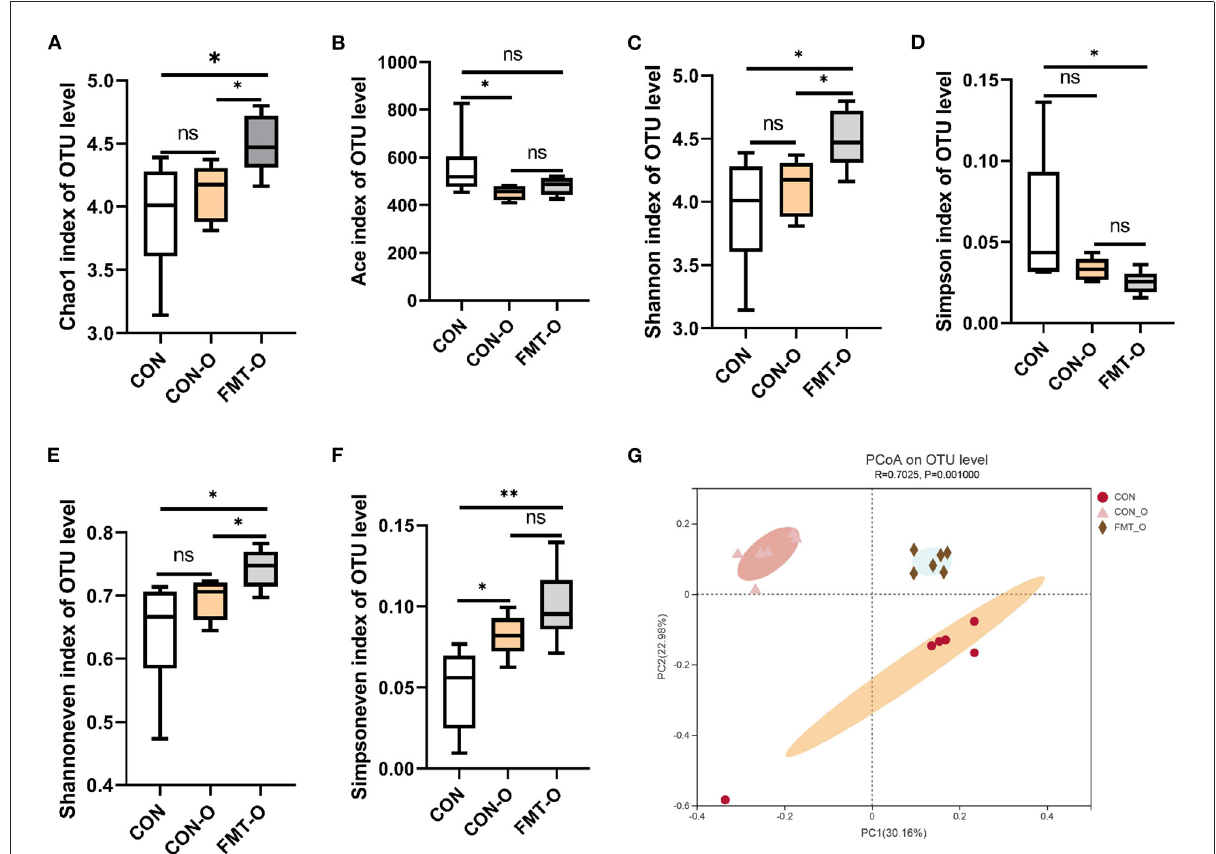
FIGURE5 Significant change of gut microbial diversity was found in older mice, which was transferable by fecal microbiota transplantation. The changes of α -diversity (A–F) . PCoA plot in β -diversity (G). The closer two sample points are, the more similar the composition of the two sample species. Different colored points and shapes indicate samples from different groups. All data are expressed as mean ± standard error (SEM). One-way ANOVA with Tukey post hoc test was conducted. * p < 0.05, ** p < 0.01; ns, no